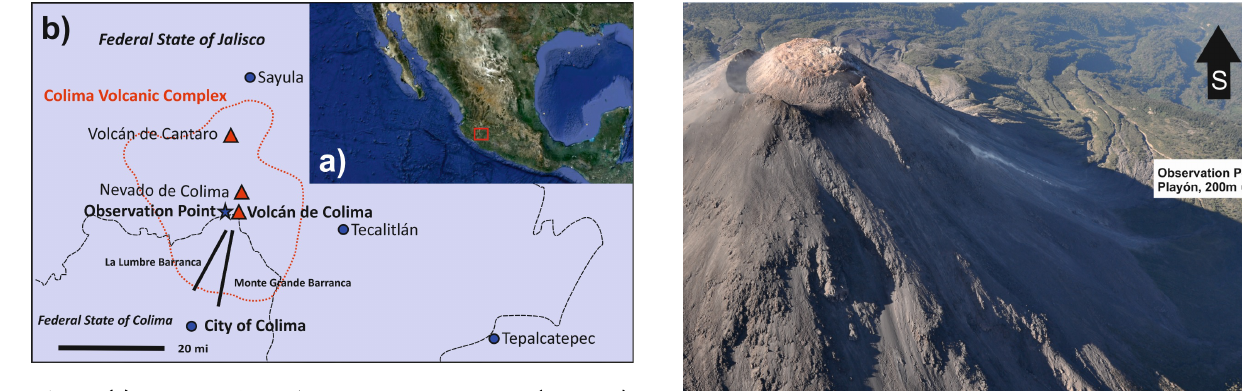
Fig. 1. (a) Position of Volc´an de Colima in Mexico (Red box); (b) map showing the Colima Volcanic Complex with the extinct volcanoes Volc´an de C´antaro and Nevado de Colima and the active Volc´an de Colima (red triangles). Two black lines south of Volc´an de Colima show the two main ravines leading towards the City of Colima; in the case of dome collapse events, such ravines guide pyroclastic flows. Also the observation point Play´on in the west of Volc´an de Colima where data for this study has been collected is shown (blue star).